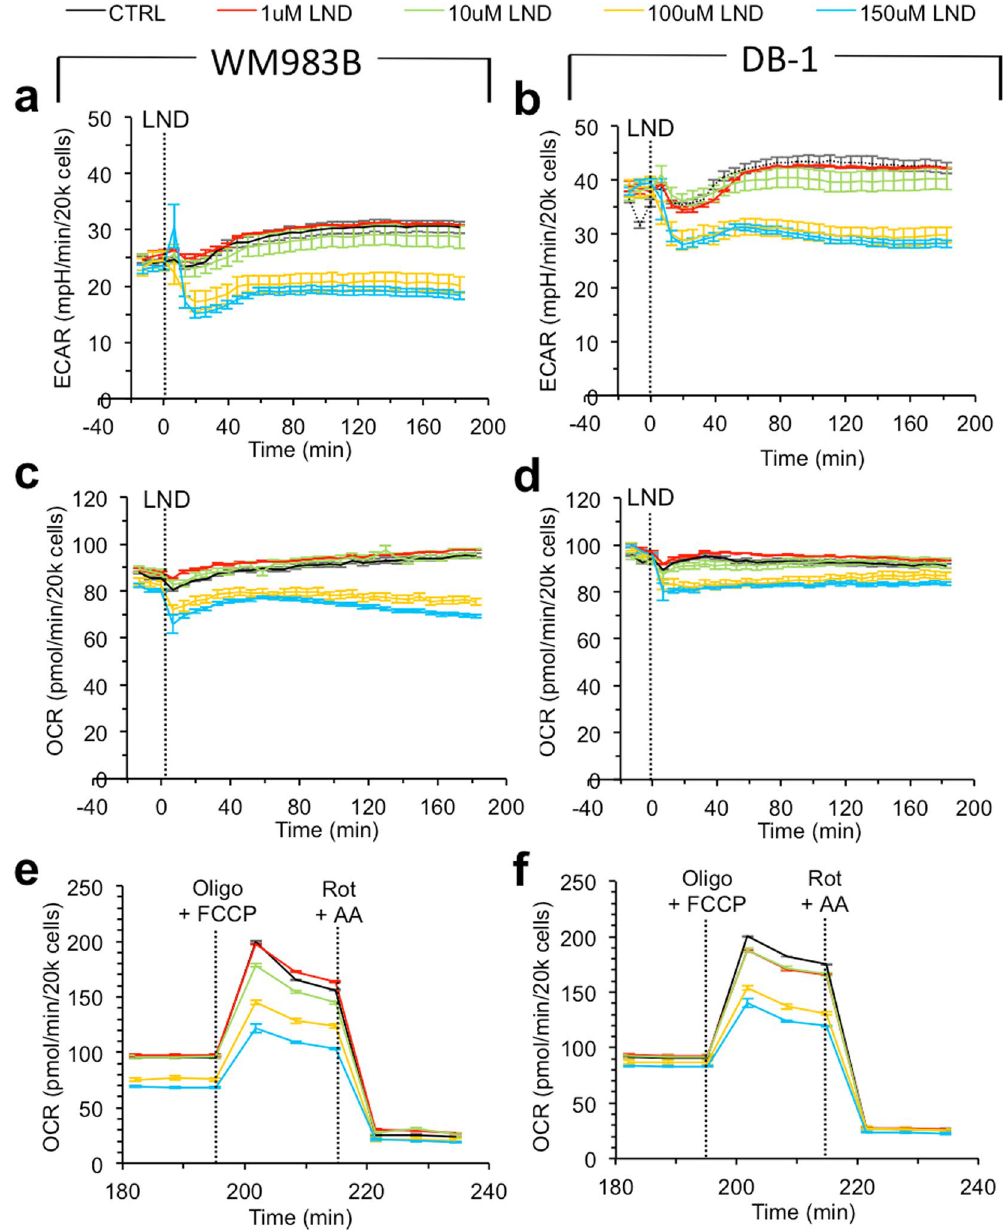
Figure 2. Lonidamine (LND) induces a concentration-dependent decrease in metabolic rates in WM983B and DB-1 human melanoma cells. For WM983B and DB-1, respectively, ( a , b ) show extracellular acidification rate (ECAR) vs. time after LND treatment. ( c , d ) show oxygen consumption rate (OCR) vs. time after LND treatment. ( e , f ) show OCR vs. time after LND treatment upon addition of oligomycin (Oligo) with carbonyl cyanide 4-(trifluoromethoxy) phenylhydrazone (FCCP), then rotenone (Rot) with antimycin A (AA). Data shown as mean ±